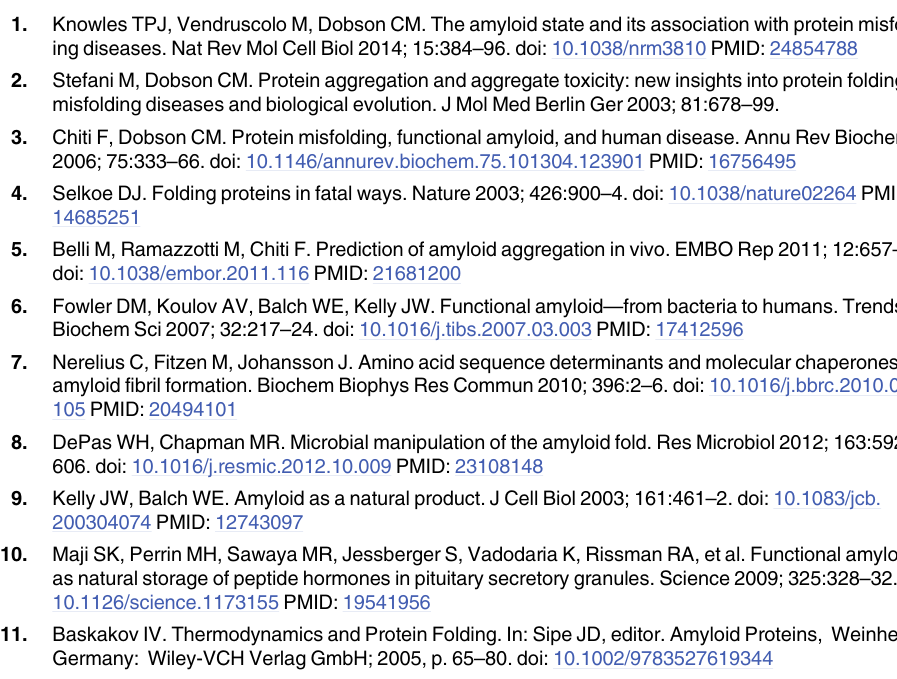
S2 Table. Input parameters and considerations made to classify a sequence as amyloido- genic from the provided outputs, organized by prediction